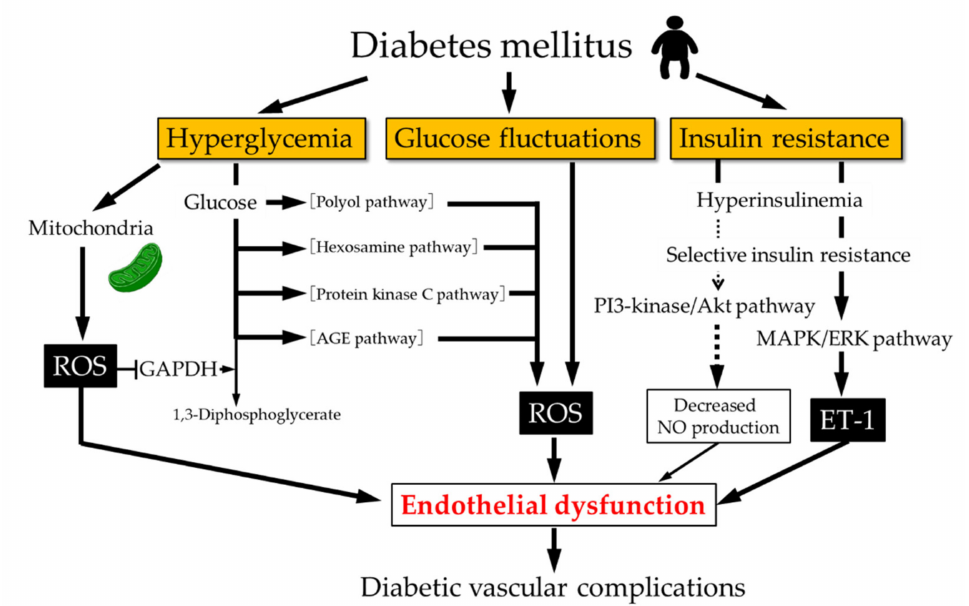
Figure 1. Mechanisms of endothelial dysfunction in diabetic patients. Chronic hyperglycemia, acute glucose fluctuations, and insulin resistance are involved in endothelial dysfunction in diabetic patients. ET-1, endothelin-1; ROS, reactive oxygen species; AGE, advanced glycation end products; PI3-kinase, phosphoinositide 3-kinase; MAPK, mitogen-activated protein kinase; ERK, extracellular signal-regulated